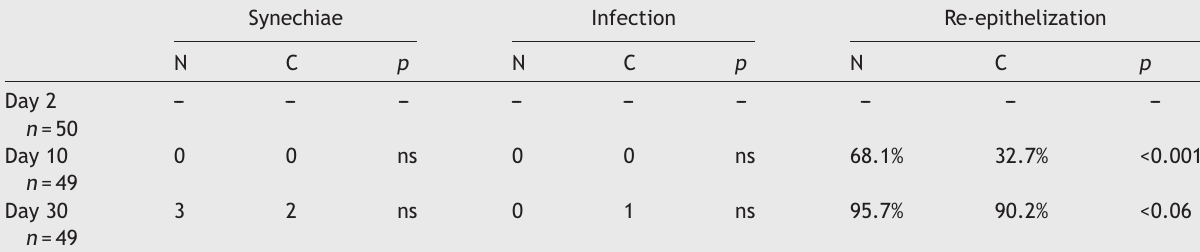
Table 2 Results of synechiae, infection, and re-epithelization between groups. Synechiae